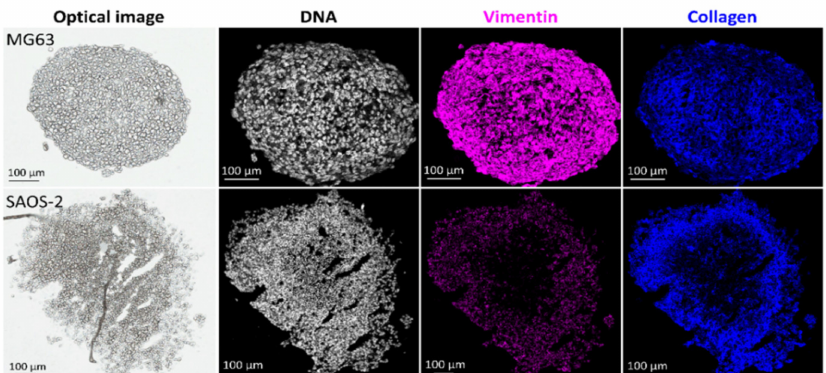
Figure 11. Representative IMC images of protein marker distributions within the OS aggregoid models. Scale bar: 100 µ m. DNA intercalator identified individual cells within the aggregoid sections. Protein markers vimentin and collagen expressed identified structural components within the aggregoid